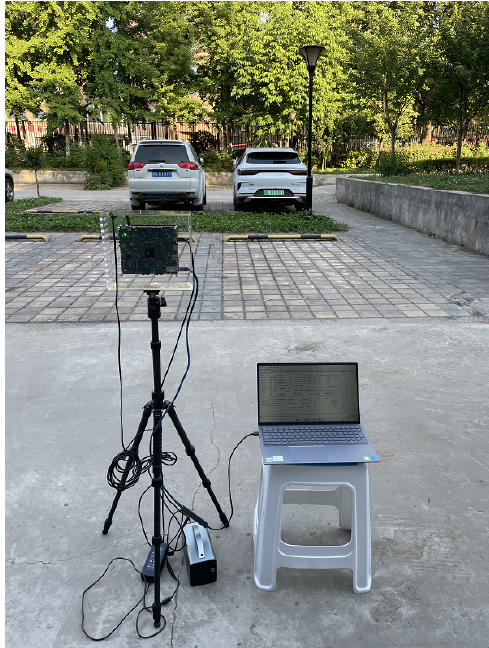
Figure 11. Experimental scenario.